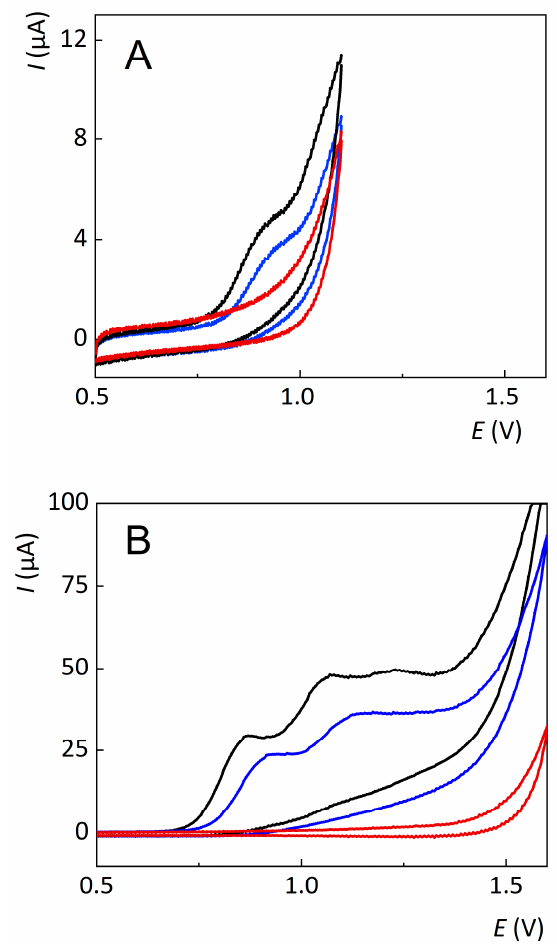
Figure 3. Cyclic voltammograms of abacavir solution in ammonium acetate (c = 0.20 mol L − 1 ) at pH = 7.0 (black line is the first scan, blue line is the second scan) and the basic electrolyte (red line) on platinum ( A ) and BDD electrodes ( B ).